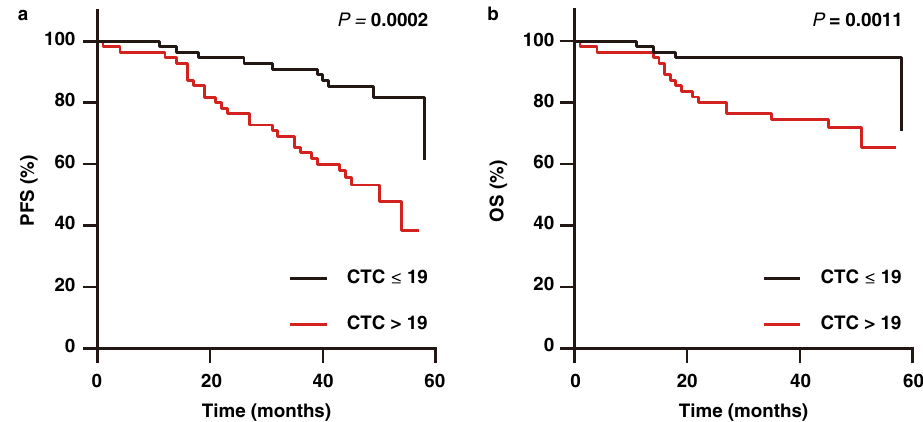
Figure 2. Kaplan–Meier curves showing estimated PFS ( a ) and OS ( b ) for patients with baseline CTC negativity (CTC ≤ 19) and CTC positivity (CTC > 19).